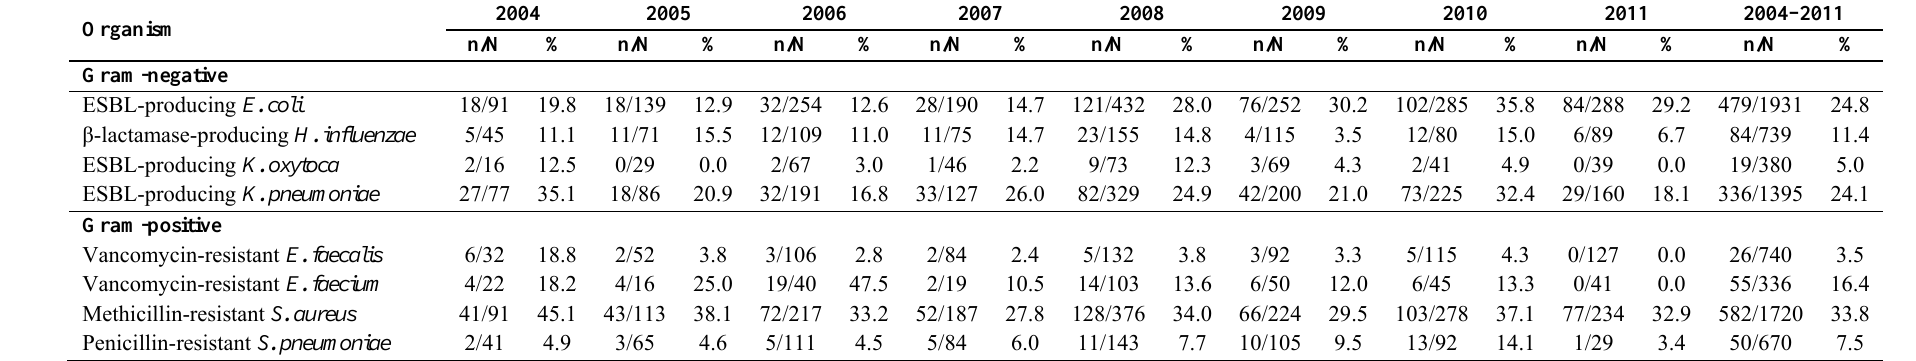
Table 6. MIC (mg/L), antimicrobial susceptibility (%S), and antimicrobial resistance (%R) for resistant Gram-negative and Gram-positive 90 isolates collected in Italy during T.E.S.T. 2004–2011.